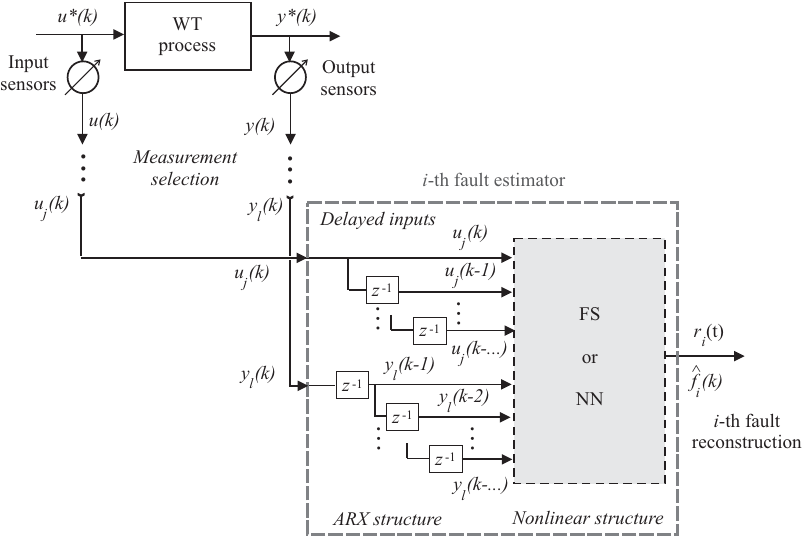
Figure 3. General scheme for fault